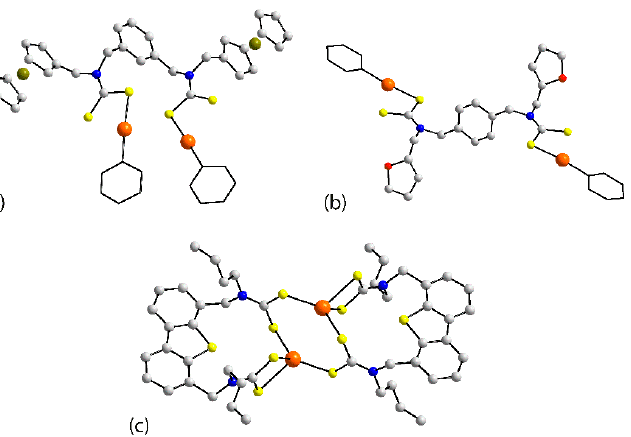
Figure 14. Molecular structures of ( a ) (PhHg) 2 (L 12 ) in the crystal of 48 , ( b ) (PhHg) 2 (L 19 ) in 49 and ( c ) Hg 2 (L 20 ) 2 in 50 . ( c ) Hg 2 (L 20 ) 2 in 50